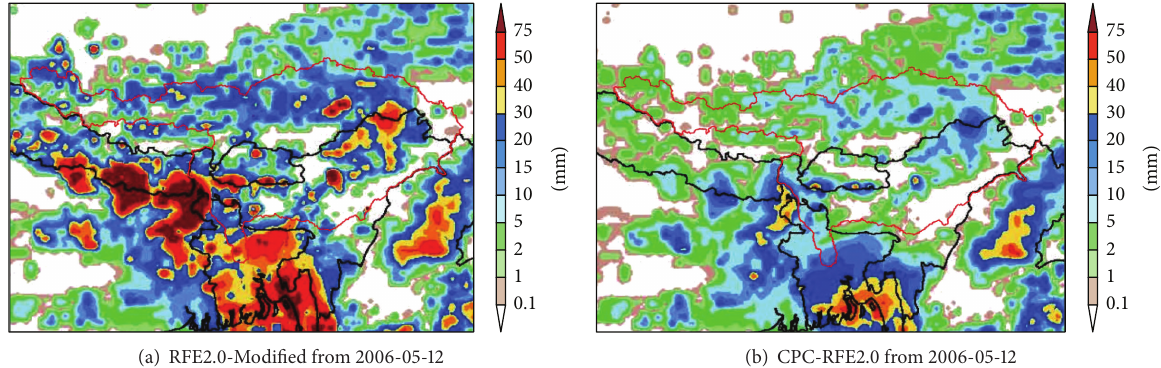
Figure 2: Comparison of RFE2.0-Modified (a) and CPC-RFE2.0 (b) at the 0.1 ∘ (24 hours) spatial (temporal) resolution for May 12, 2006.